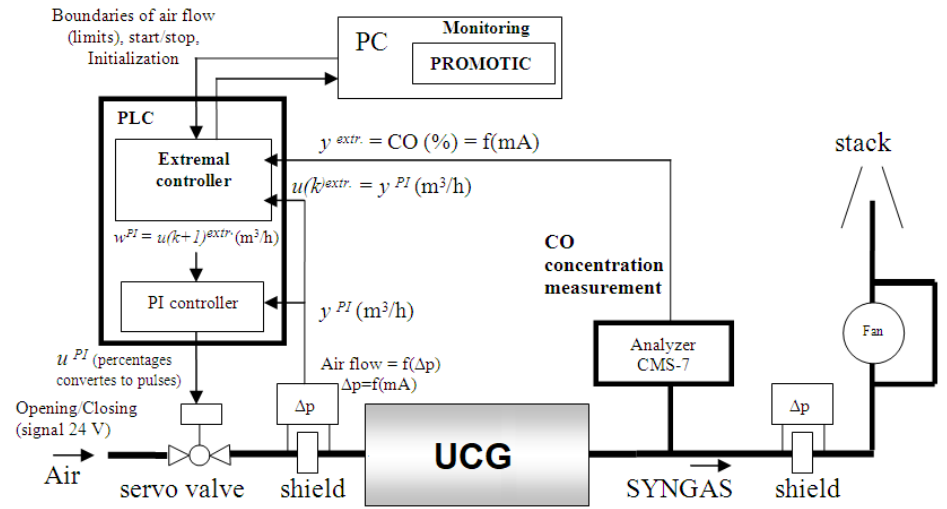
Figure 7. Implementation of two-level extremum seeking control.